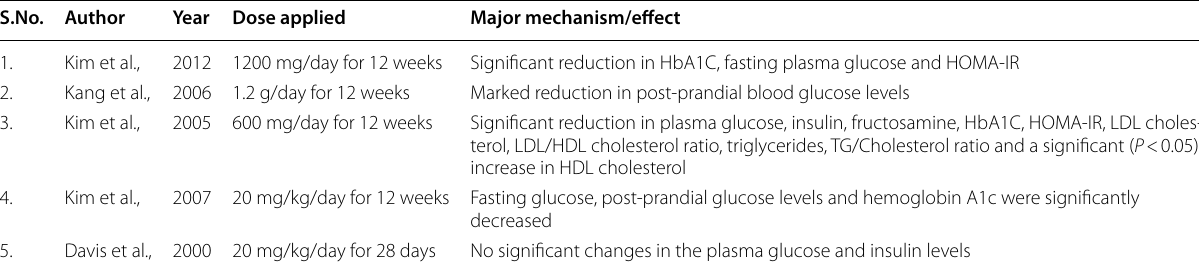
Table 2 Summary of the effects of d -pinitol on patients with diabetes